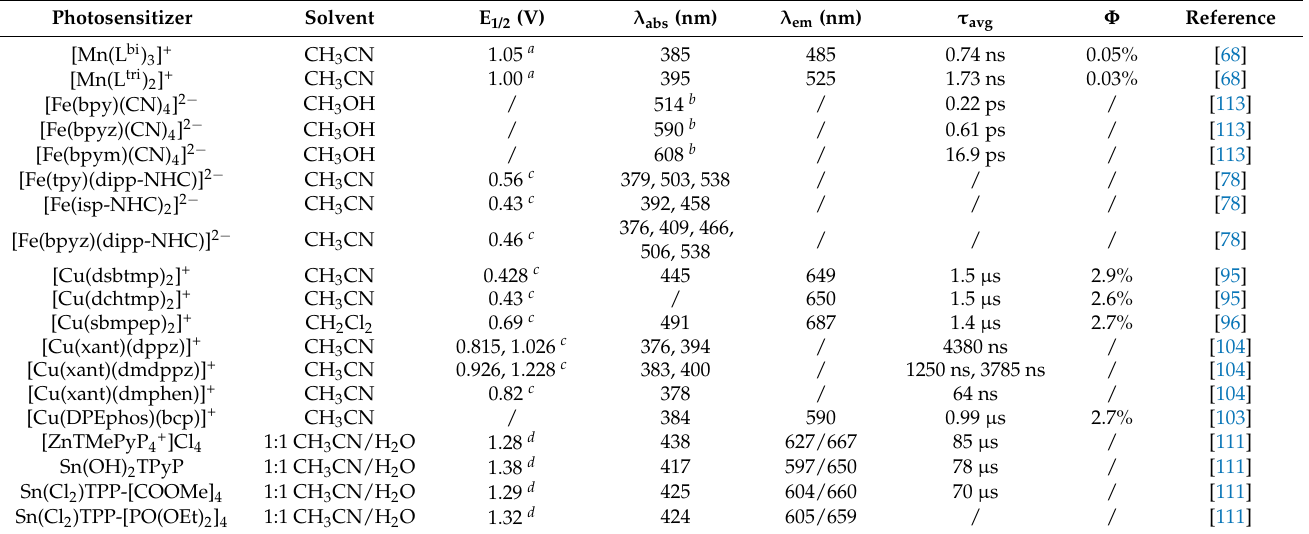
Table 3. Summary of the properties of the partial noble-metal-free photosensitizers in this review.